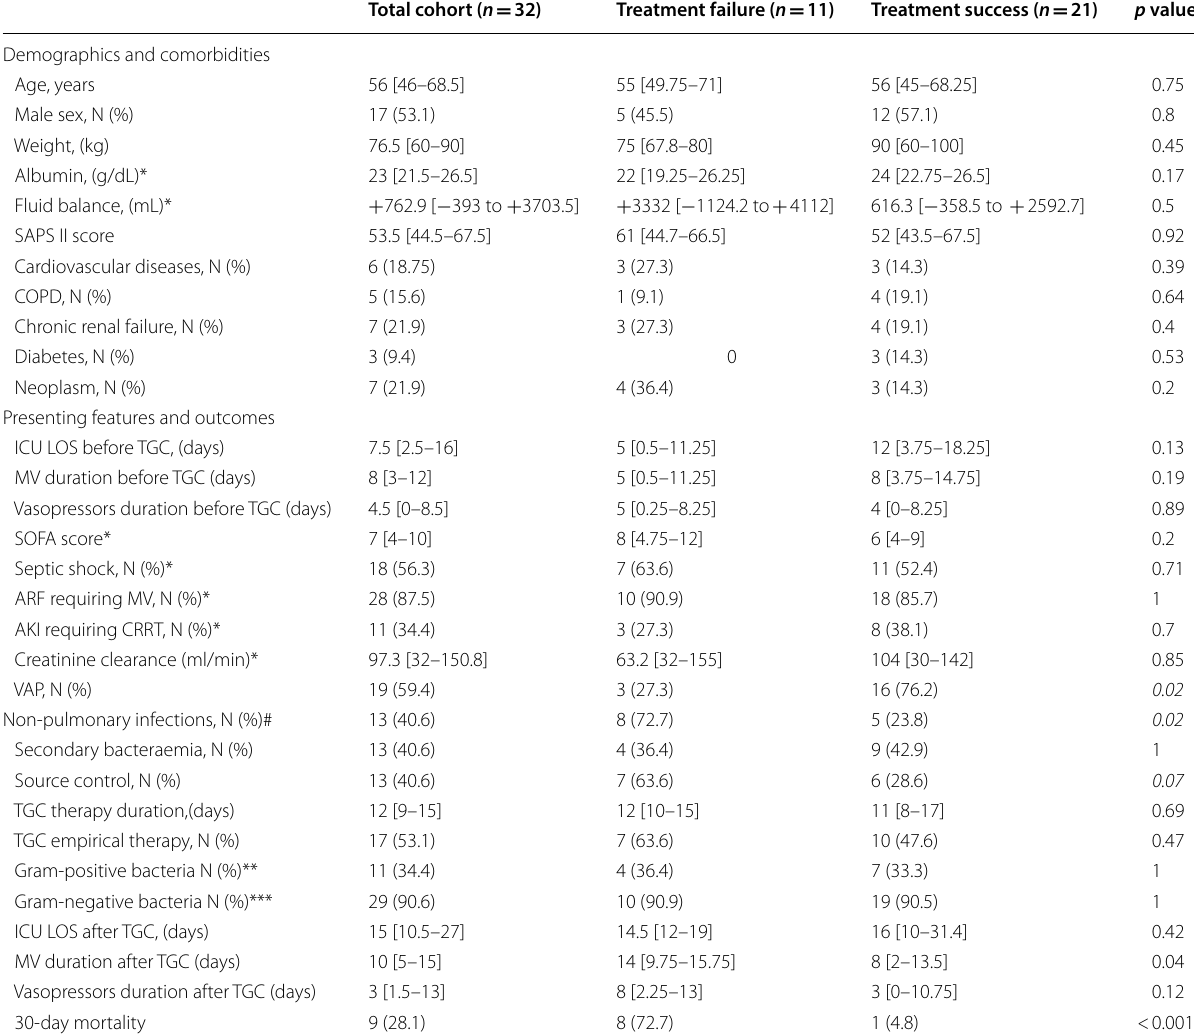
Table 1 Baseline patients’